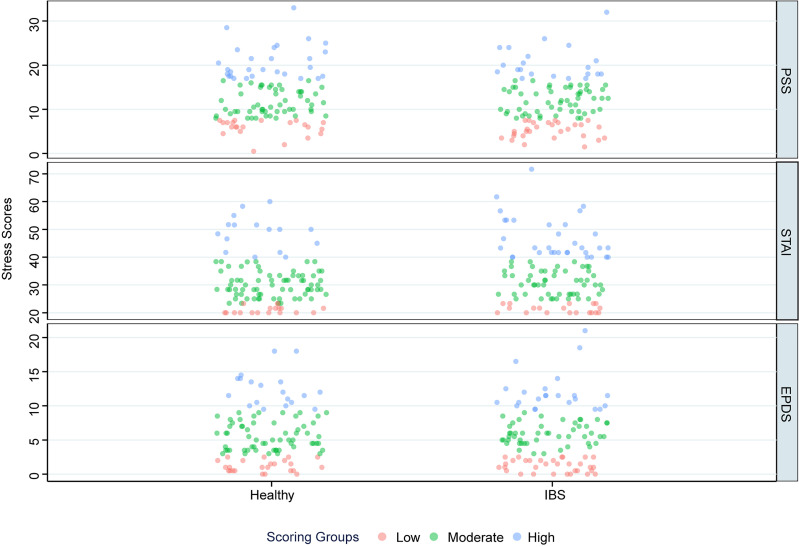
Stratification of perceived stress, anxiety, and depression measures into low-scoring (PSS ≤ 7.5; N = 22 and 29 | STAI ≤ 23.3; N = 18 and 19 | EPDS ≤ 2.5; N = 24 and 32), moderate-scoring (PSS > 7.5 and < 17; N = 54 and 55 | STAI > 23.3 and < 40; N = 70 and 53 | EPDS > 2.5 and < 9.5; N = 61 and 50), and high-scoring groups (PSS ≥ 17; N = 28 and 21 | STAI ≥ 40; N = 16 and 33 | EPDS ≥ 9.5; N = 19 and 23) for healthy and IBS cohorts, respectively.